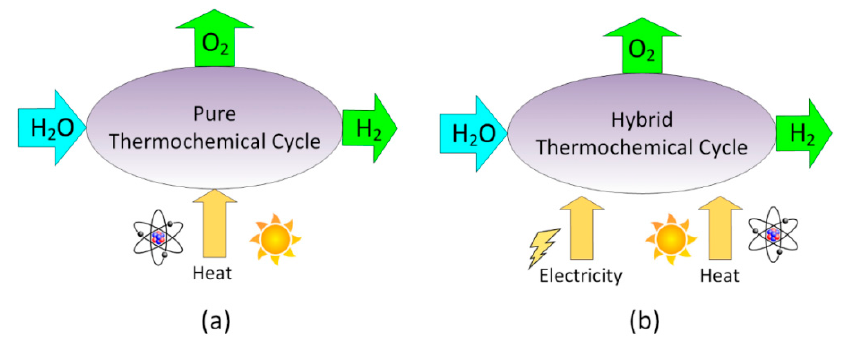
Figure 4. Schematic representation of pure ( a ) and hybrid ( b ) thermochemical cycles [10].